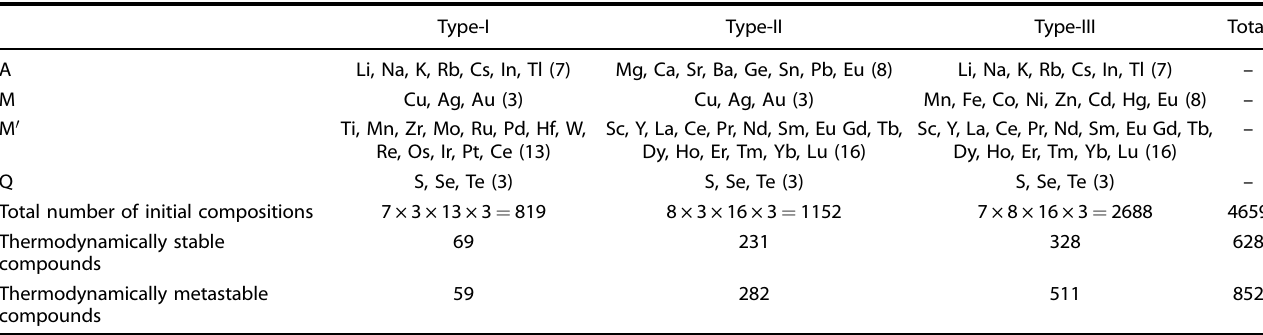
Table 1. A table summarizing the design and discovery of materials through prototype